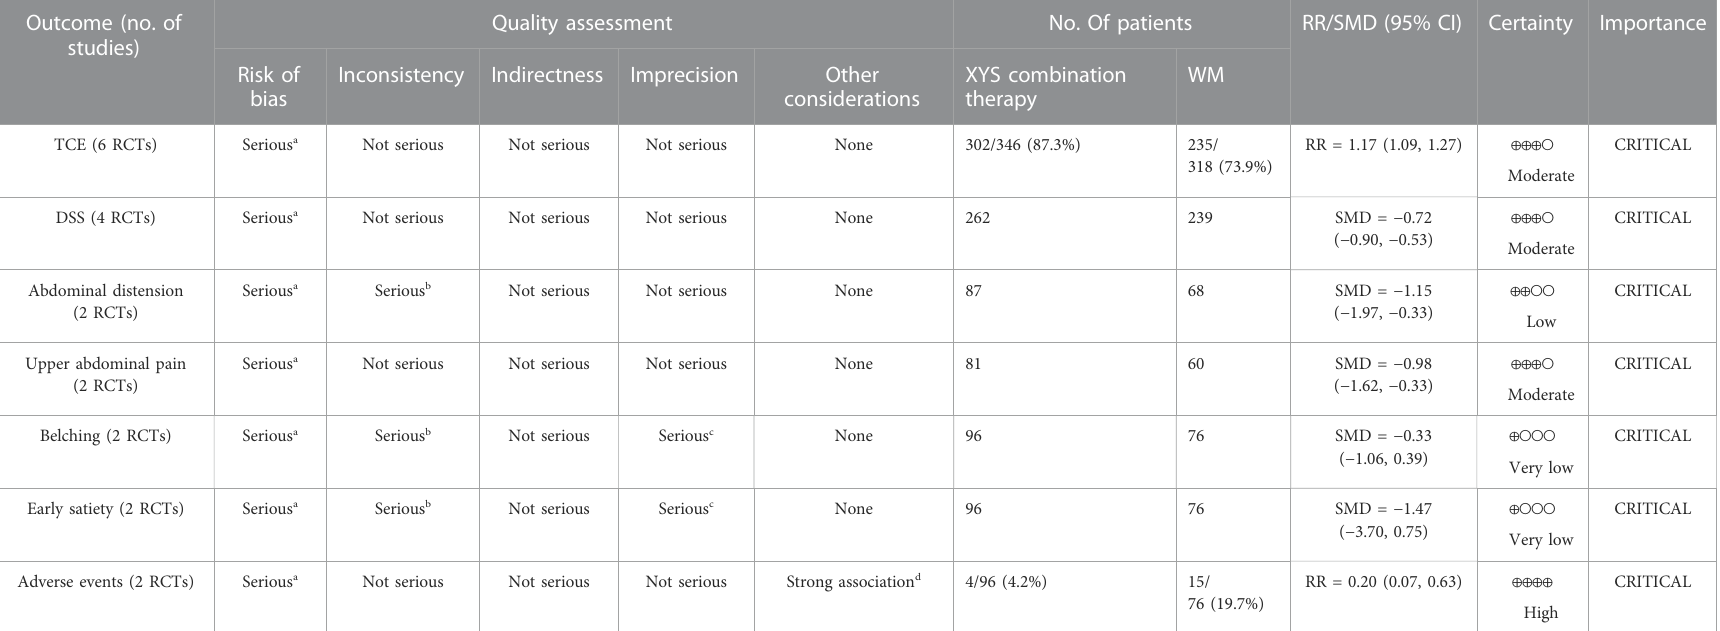
TABLE 4 GRADE evidence pro fi le. Outcome (no. of